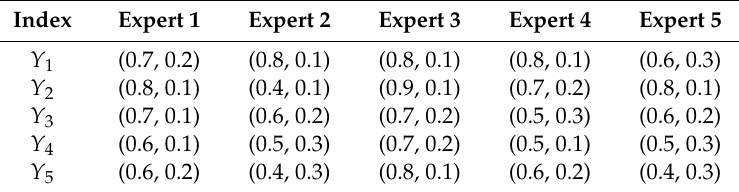
Table 7. Experts’ judgment information on the importance of di ff erent